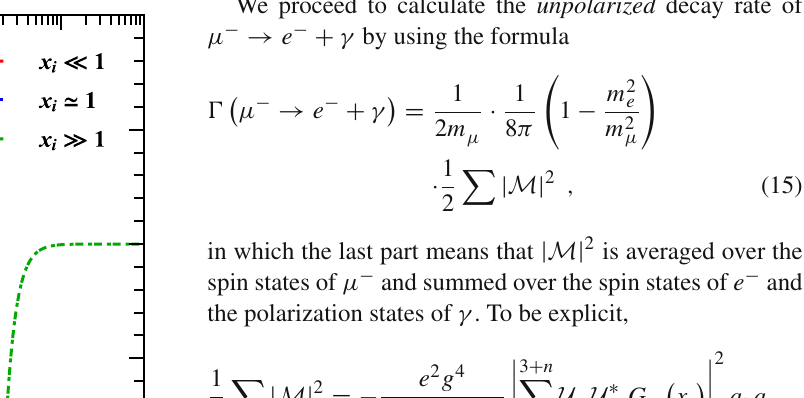
Fig. 4 A numerical illustration of the relative error η the exact result of G γ Eq. (14), in which x taken to plot η (cid:8) 1, x i